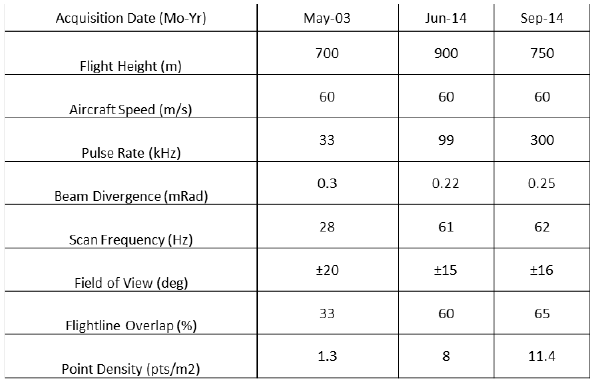
Table 1. ALS data collection